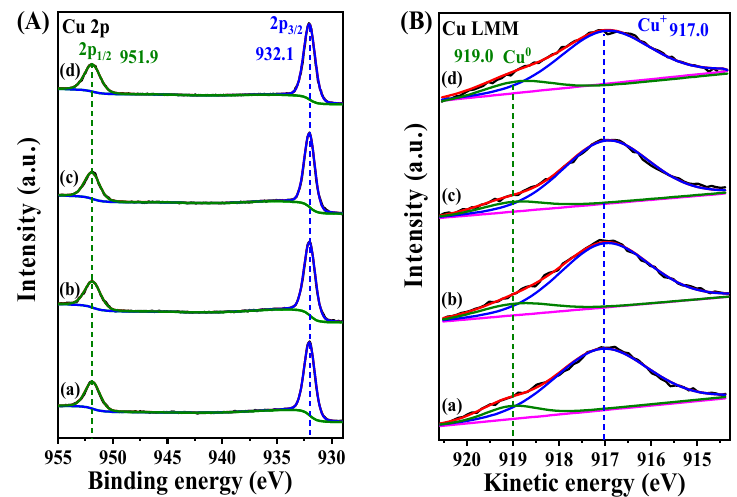
Figure 3. ( A ) Cu 2p core level spectra: ( a ) Cu 2 O / TiO 2 , ( b ) Au@TiO 2 / Cu 2 O, ( c ) Au@Cu 2 O / TiO 2 , ( d )